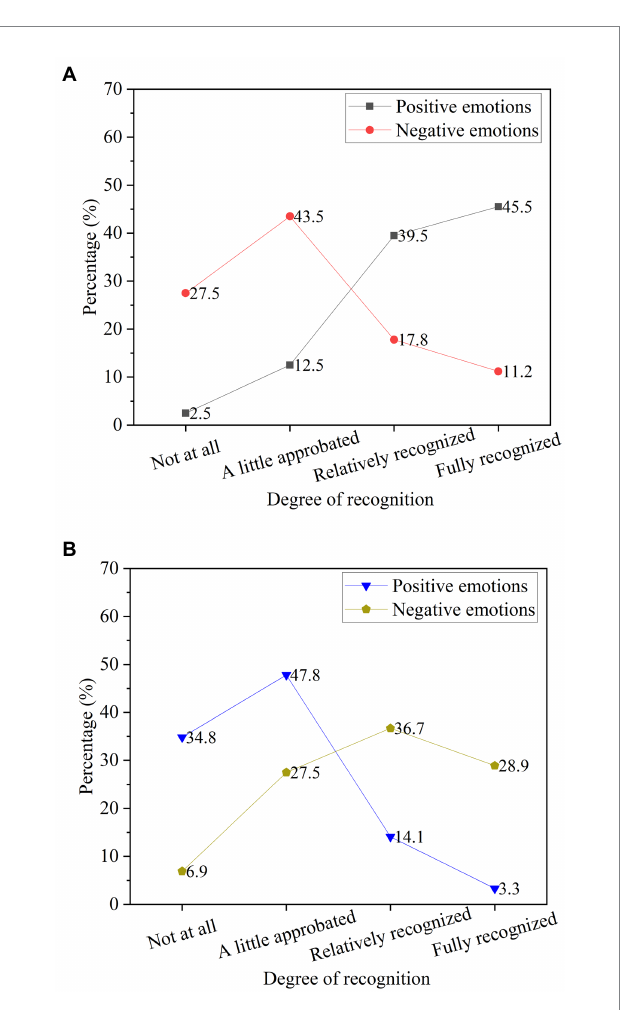
FIGURE 12 The influence of psychological emotions on the problem solving of college students. (A) The recognition of different psychological emotions for calmly analyzing and resolving conflicts; (B) The recognition of different psychological emotions for intensifying conflicts and behavioral